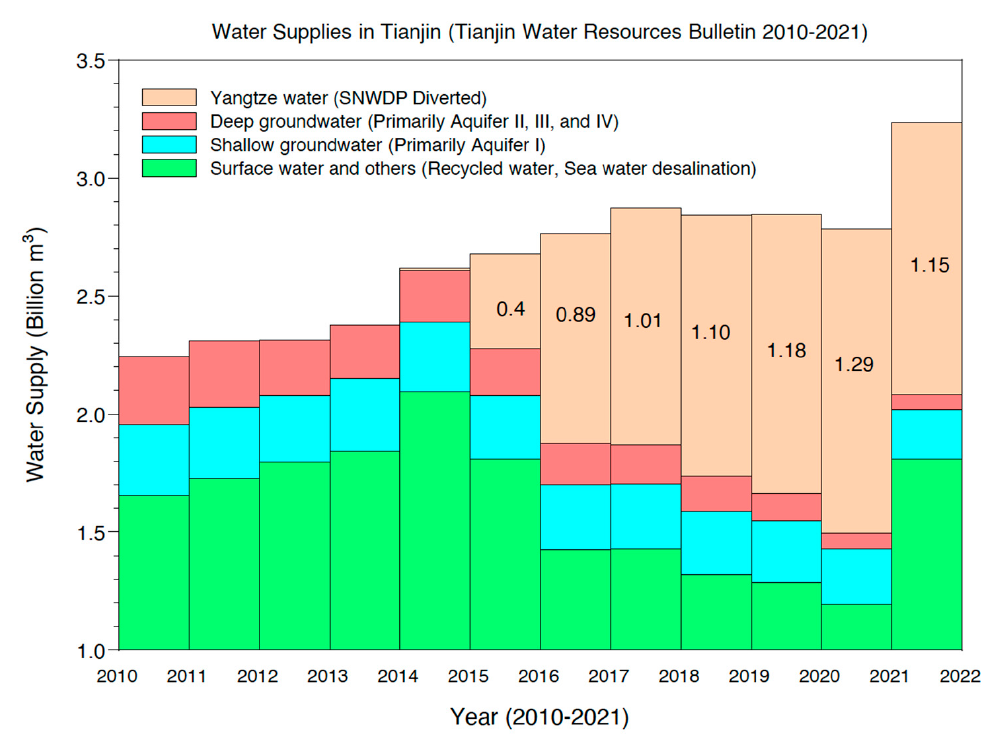
Figure 3. Water supplies in Tianjin from 2010 to 2021. The total water supply transformed to Tianjin by the South-to-North Water Diversion (SNWD) project was approximately 7 billion m 3 from 2015 to 2021. (Data source: Tianjin Water Resources Bulletins, 2010 to 2021